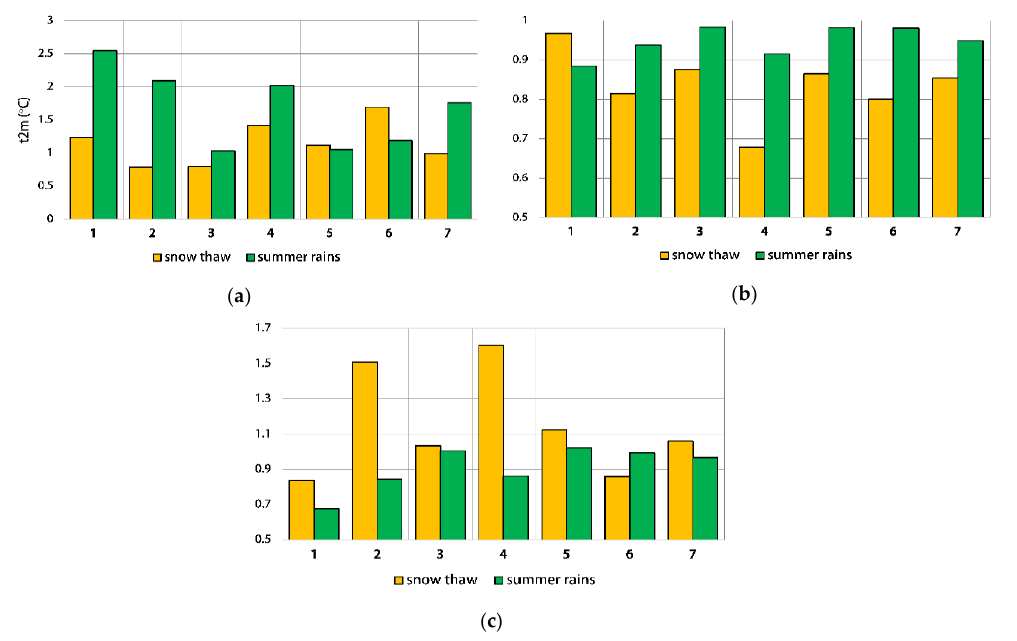
Figure 8. Error statistics (ERA5 versus observational data) for daily t2m: root mean square error (RMSE) ( a ), correlation coefficient ( b ), the ratio of the standard deviations (STD) of the ERA5 reanalysis and observed values ( c ) for seven stations and the nearest grid points of ERA5 reanalysis for snow thaw ( orange ) and summer rains ( green ) periods.